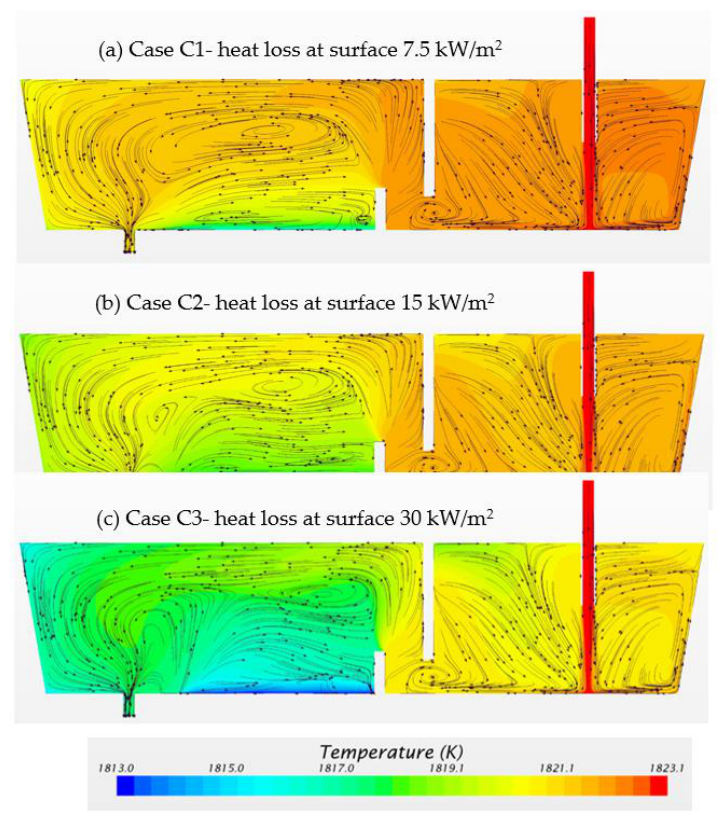
Figure 15. Temperature and flow movement for three cases with different surface heat losses: ( a ) Case C1: 7.5 kW/m 2 ; ( b ) Case C2: 15 kW/m 2 ; ( c ) Case C3: 30 kW/m 2.